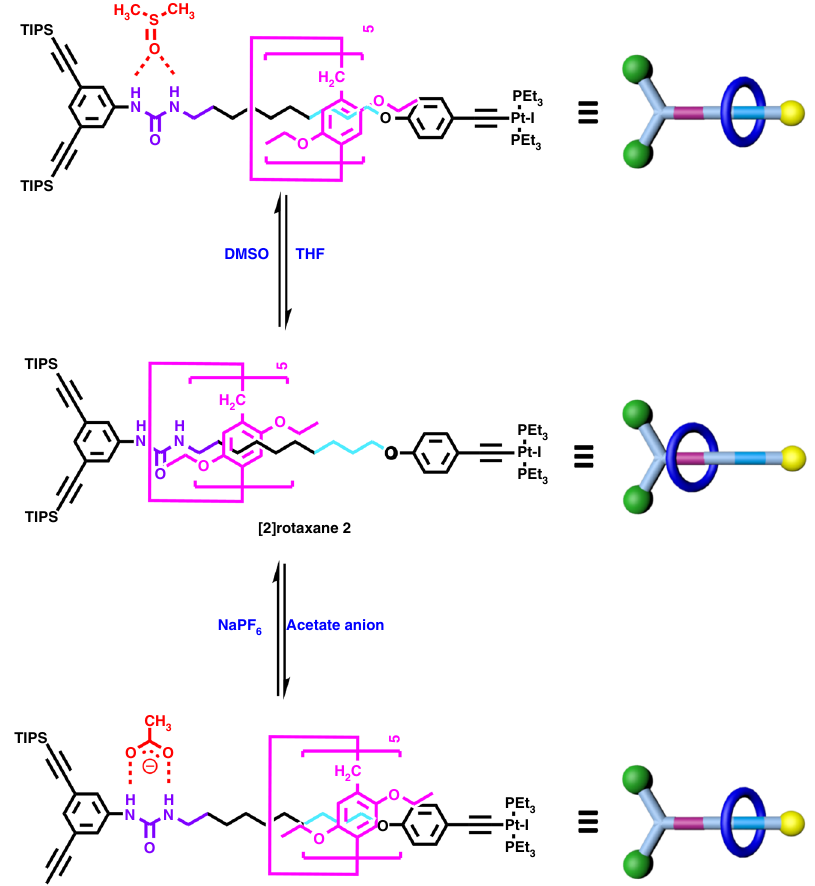
Fig. 2 Cartoon representation of the solvent- and anion-induced switching motions of DEP5 ring in [2]rotaxane